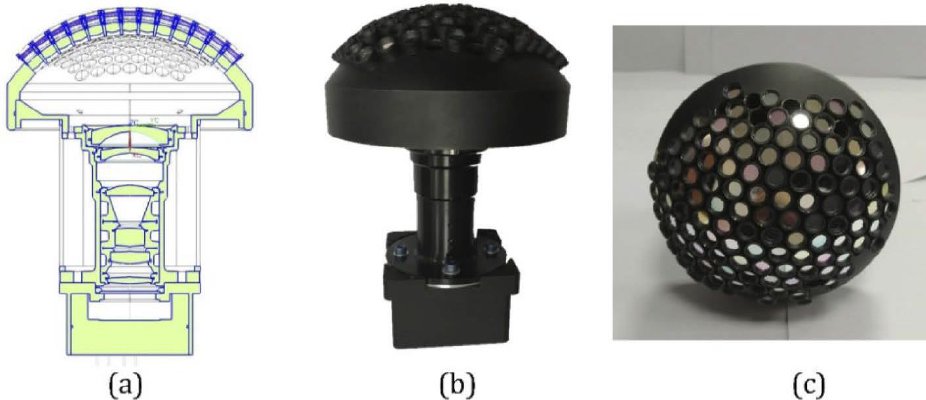
Figure 49. The prototype of BMCCEC: ( a ) its mechanical structure, ( b ) a photograph of BMCCEC, ( c ) a photograph of the multispectral curved compound eye.